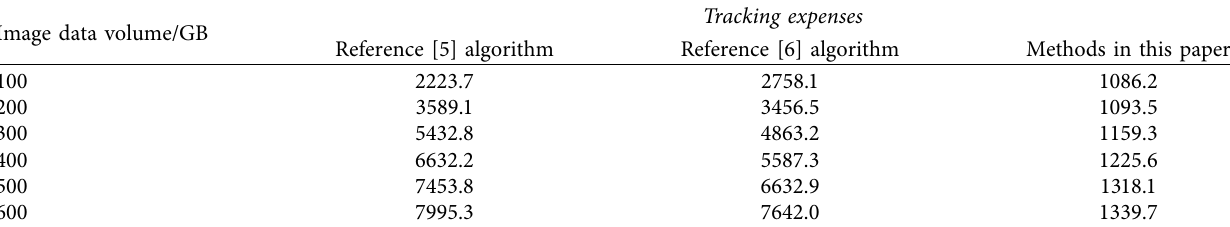
Figure 5: Comparison of tracking time of different algorithms. Table 1: Economic benefits of the different